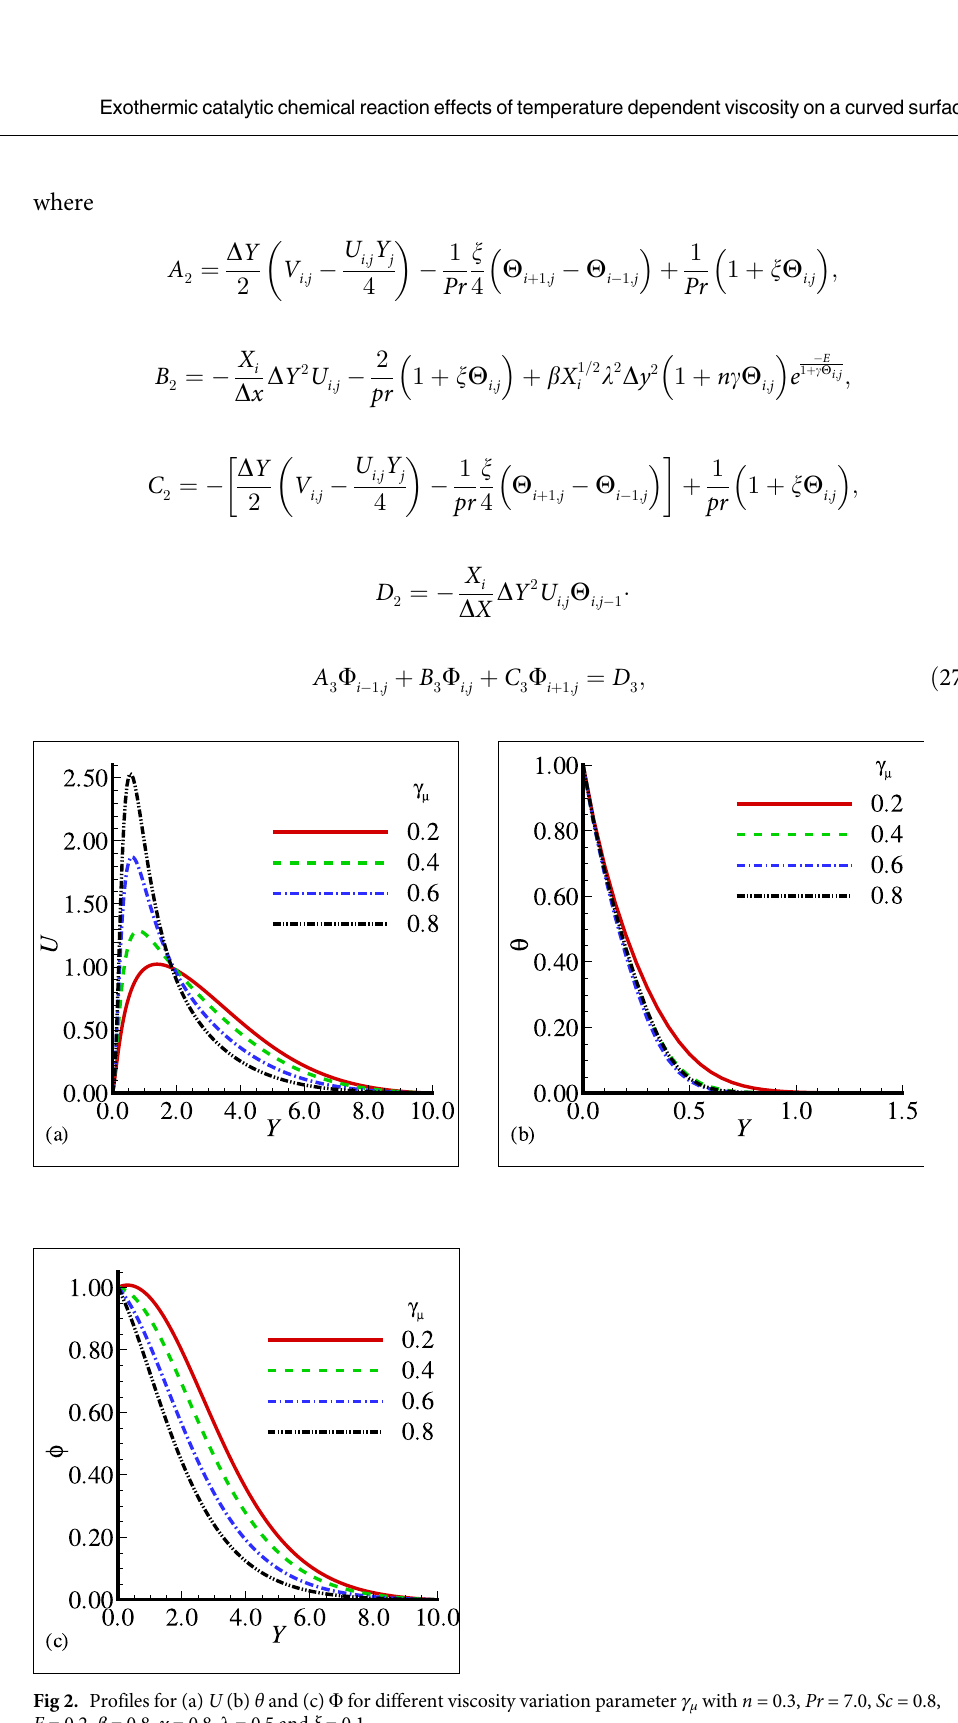
Fig 2. Profiles for (a) U (b) θ and (c) F for different viscosity variation parameter γ E = 0.2, β = 0.8, γ = 0.8, λ = 0.5 and ξ =